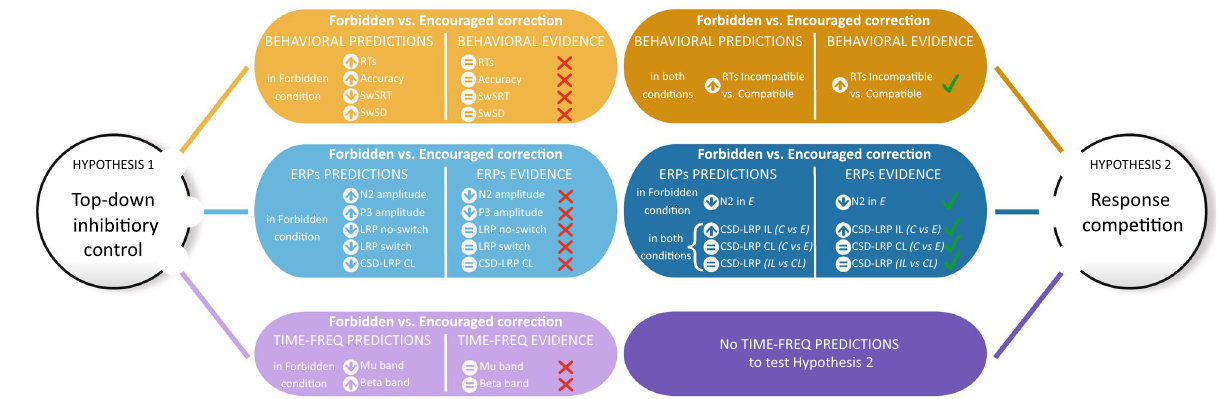
Figure 5. Flowchart of the behavioral (orange), ERPs (blue) and time–frequency (purple) predictions and evidences for both the top-down inhibitory control (pale) and the response competition (dark) hypotheses. Green check marks and red crosses indicate whether data supports or refutes the hypothesis. IL, ipsilateral; CL, contralateral; C, correct; E,